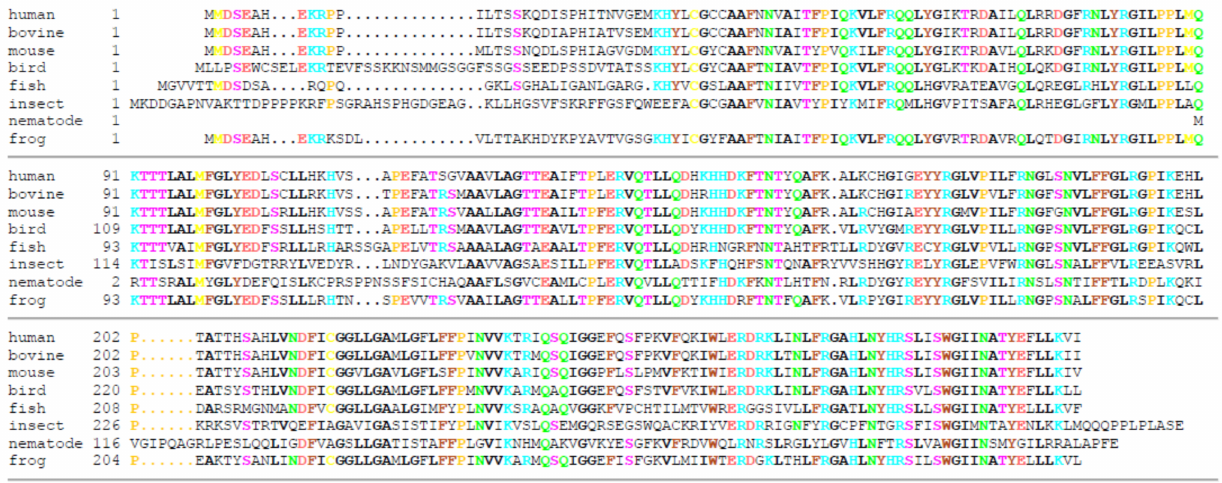
Figure 4. Multiple sequence alignment of representative SLC25A51 homologs from various species: human ( Homo sapiens , NP_219480), bovine ( Bos taurus , NP_001092864), mouse ( Mus musculus , NP_001009949), bird ( Gallus gallus , XP_003643156), fish ( Danio rerio , XP_002664343), insect ( Drosophila melanogaster , NP_651766), nematode ( Caenorhabditis elegans , NP_501642), and frog ( Xenopus tropicalis , NP_001107506). The conserved residues are coloured based on the property of the side chain: hydroxyl group S and T (magenta); amide group N and Q (green); positively charged R, K, and H (cyan); negatively charged D and E (red); aromatic F, W, and Y (brown); sulfur-containing C and M (light yellow); hydrophobic A, G, L, I, and V (black and bold); P (dark yellow).